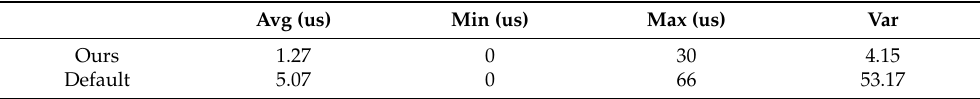
Table 5. Comparison of